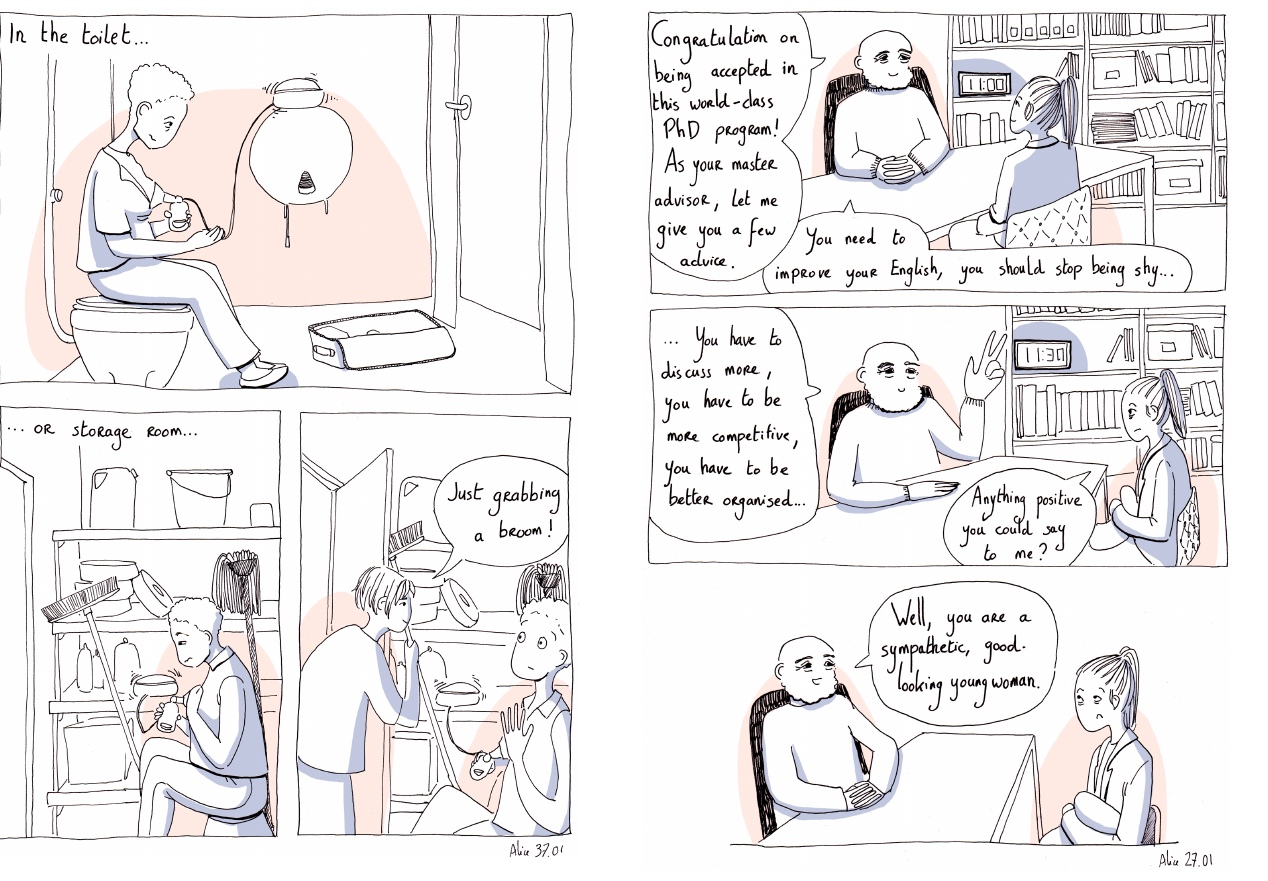
Figure 7. A young female scientist is reduced to her physical ap- pearance. Example of the “Objectification of women” category. Comic strip title: “Good looking young woman” (DTRH team, 2019a; Adenis, 2019). All comics are hand-drawn by Alice Adenis – distributed under the Creative Commons Attribution 4.0